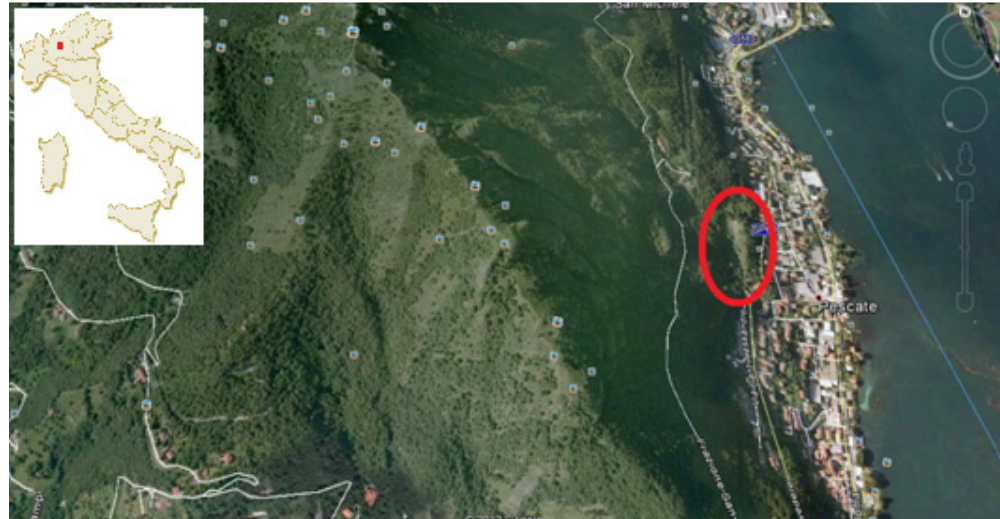
Figure 3. Pescate, Lecco, North of Italy and detailed view of the site of orchid sampling, Prato Olivino (Map from Google